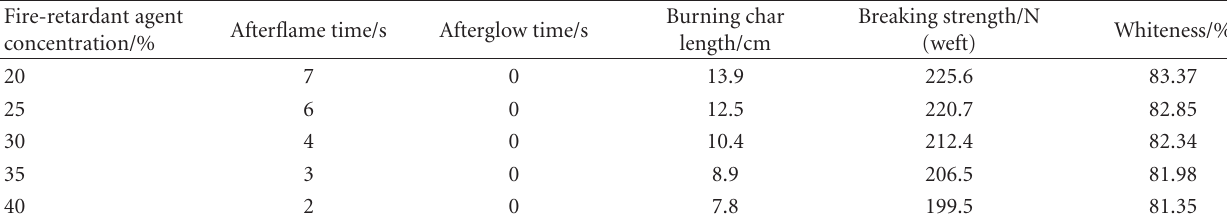
Fire-retardant agent